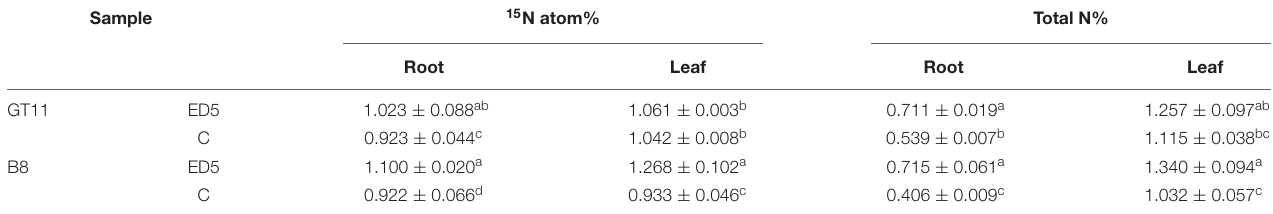
TABLE 1 | Effect of strain ED5 on percentage of 15 N and total nitrogen content in two sugarcane varieties. Sample